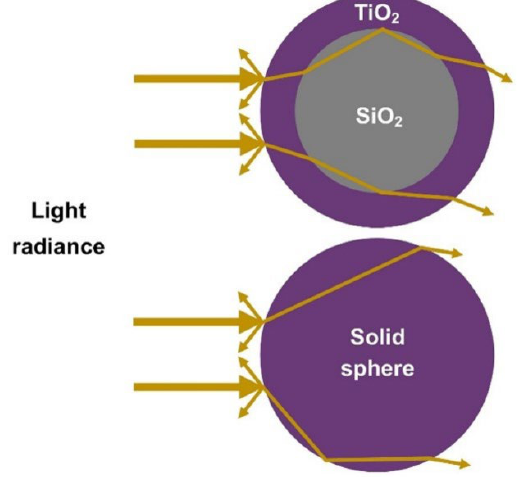
Figure 12. Schematic illustration of the incident light passing through a SiO 2 -TiO 2 core-shell and a solid sphere structure.